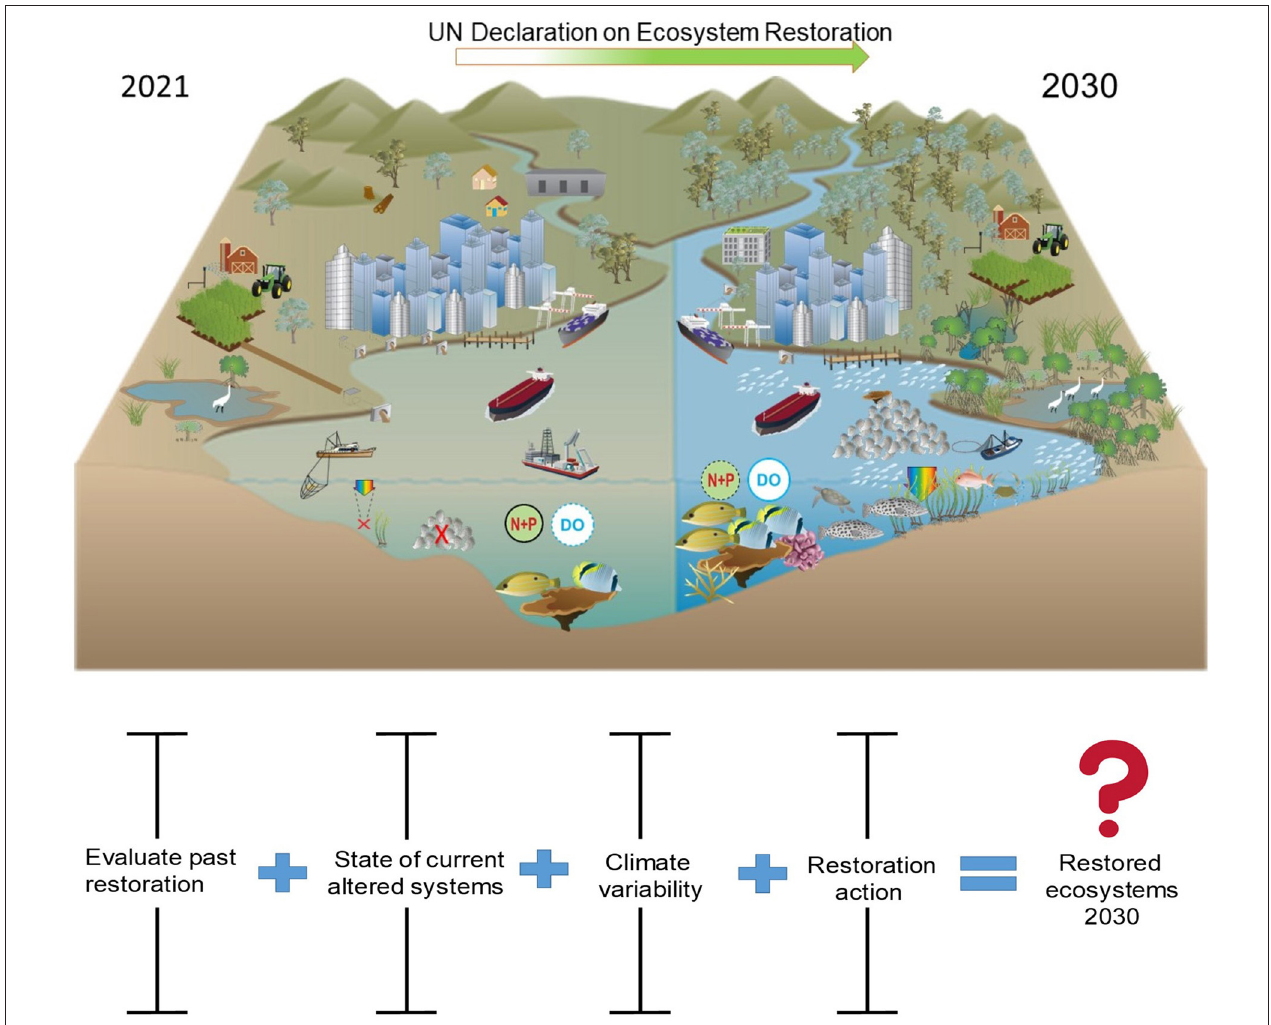
FIGURE 1 | Current state of modified and impacted coastal ecosystems and expected state following the decade of restoration. Also, shown is the uncertainty in the success of past restoration efforts, current state of altered systems, climate variability, and restoration actions that are available now or on the horizon, could mean that delivering the Decade on Ecosystem Restoration for coastal systems needs to be viewed as a means of getting things going where the benefits might take longer than a